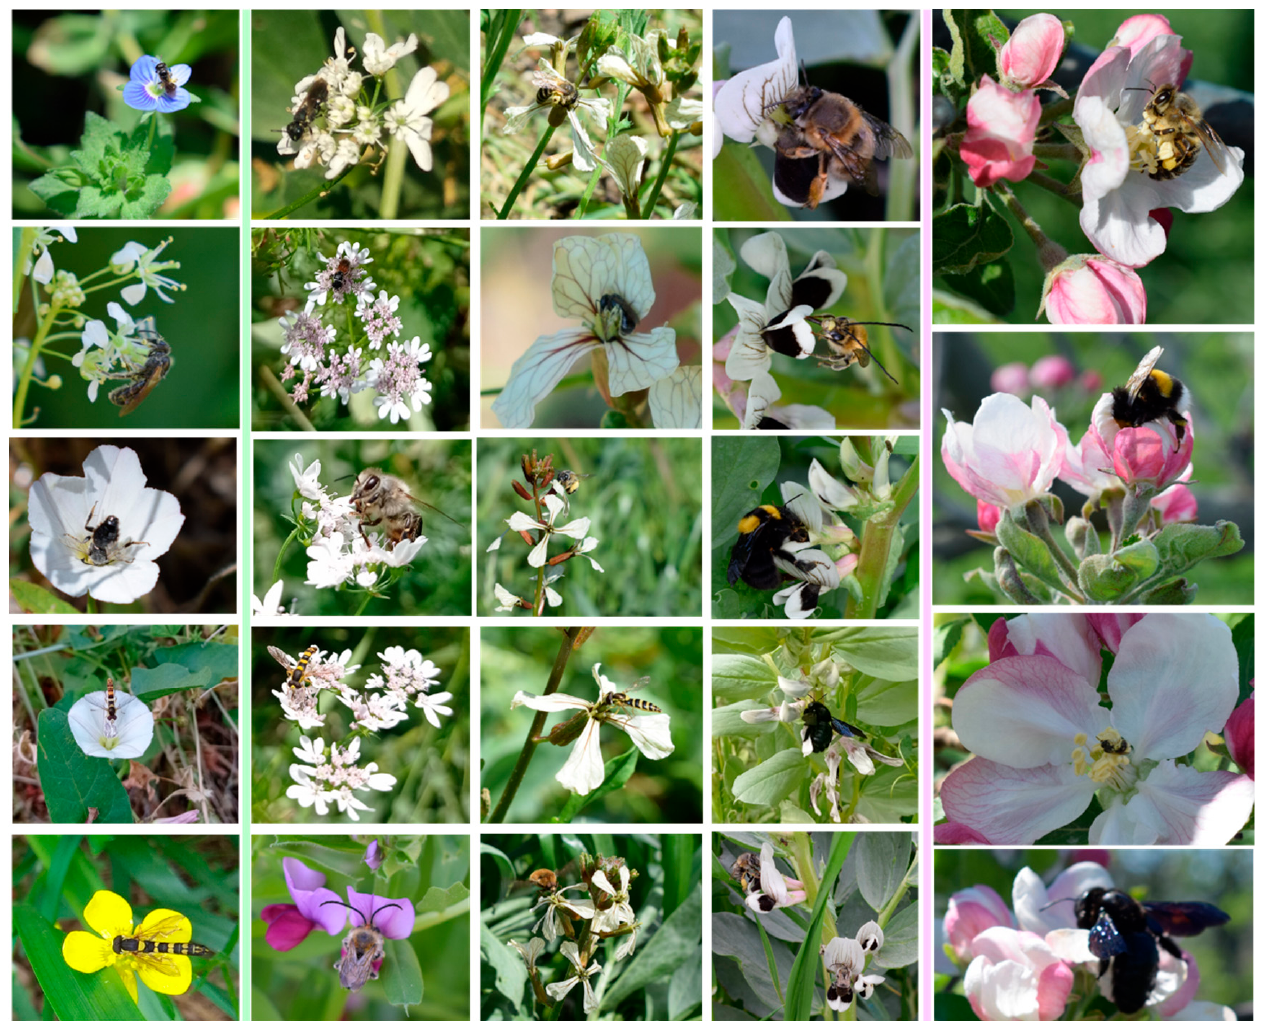
Figure 7. Insect pollinators in apple orchards in Tegea, Peloponnese, Greece, 2019–2021: on wild plant flowers (1st column): Andrena sp.— Veronica persica , Lasioglossum sp.— C. draba , S. curvicornis — C. arvensis , Syrphidae— C. arvensis , Syrphidae— Ranunculus repens ; on sown mixture flowers (2nd — 4th column): Hylaeus (Dentigera)— C. sativum , Hylaeus variegatus — C. sativum , A. mellifera — C. sativum , Syrphidae— C. sativum , Eucera sp.— V. sativa , Andrena sp.— E. sativa , Lasioglossum sp.— E. sativa , Anthophora sp.— E. sativa , Syrphidae— E. sativa , Bombyliidae— E. sativa , A. plumipes — V. faba , E. nigrescens — V. faba , B. argilaceus — V. faba , X. violaceae — V. faba , A. plumipes and Eucera sp.— V. faba ; on apple blossoms (5th column): A. mellifera-M. domestica , B. terrestris—M. domestica , Lasioglossum—M. domestica , X. violaceae—M. domestica , X. violaceae—M. domestica.